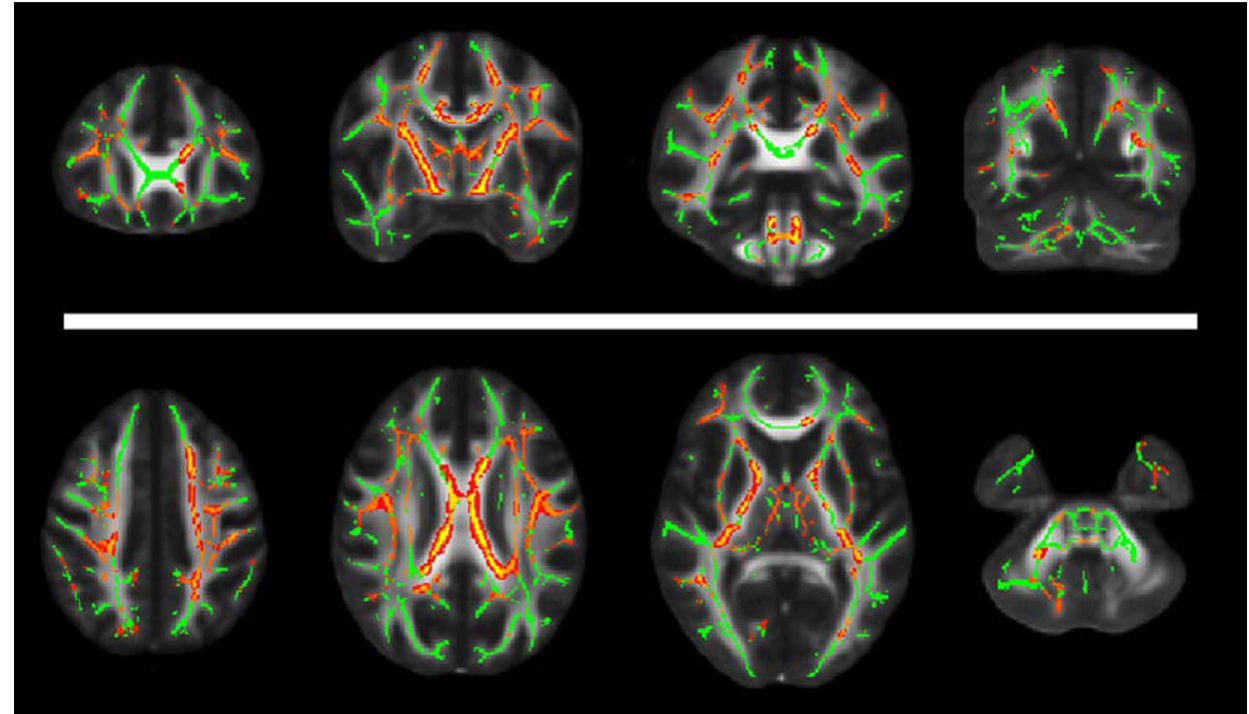
Fig. 4 Selected coronal ( upper row ) and axial ( lower row ) slices showing in red-yellow the presence of widespread regions of reduced fractional anisotropy in Fabry disease patients compared to healthy controls (results of a tract-based spatial statistics analysis reported in